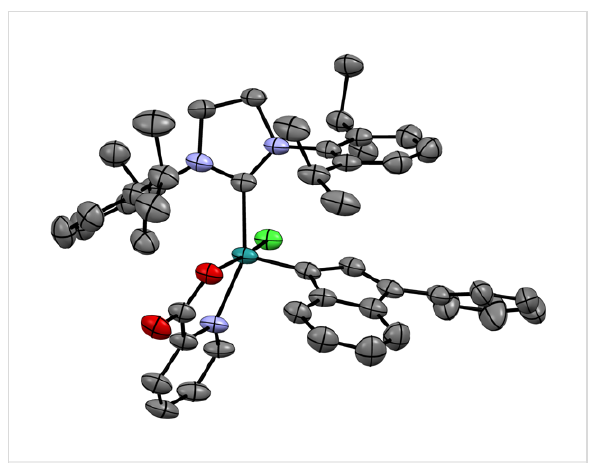
Figure 1: Solid-state structure of complex 4a from single crystal X-ray diffraction. Hydrogens have been omitted for clarity. (N in blue, C in grey, O in red, Cl in green).